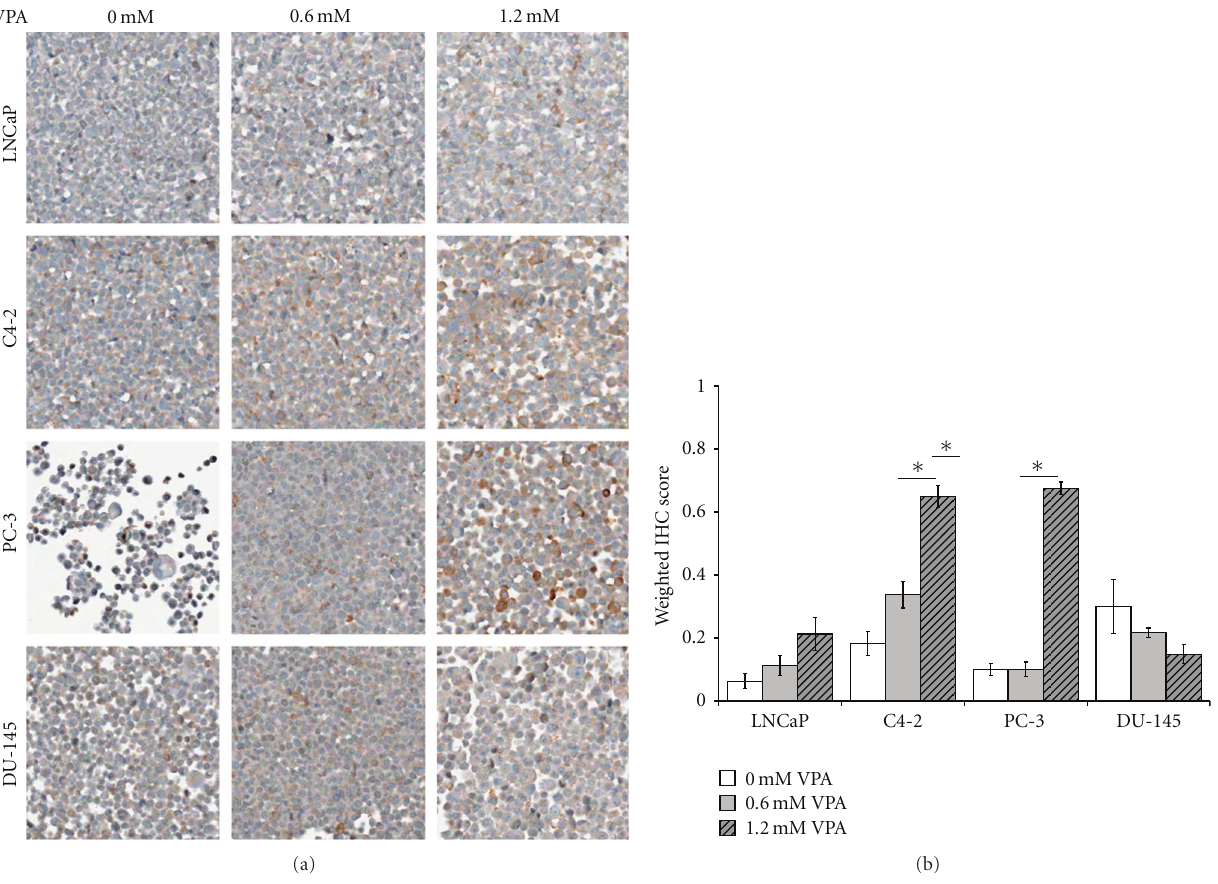
Figure 2: Synaptophysin staining in prostate cancer cells treated with VPA in vitro. (a): Representative images of synaptophysin staining for cell pellet sections from control and VPA-treated groups: LNCaP, C4-2, PC-3, and DU-145 (Scanned at 20X magnification using the APERIO imaging system). (b) Weighted scoring of IHC staining for synaptophysin ( ∗ indicates P <